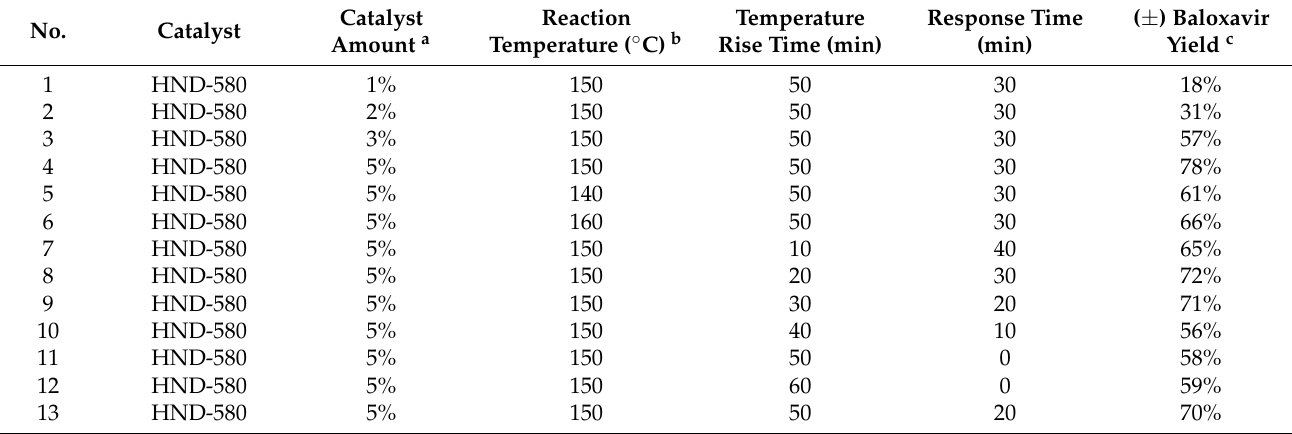
Table 2. Screening of reaction